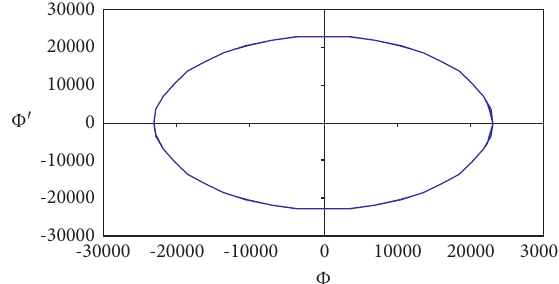
Figure 19: The stability phrase Φ ′ and Φ for case (i) in Section 4.2.